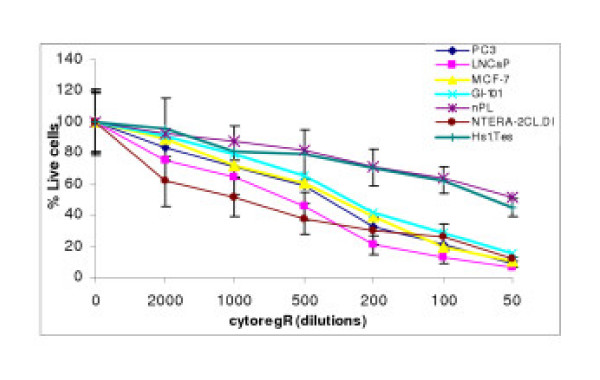
Growth inhibition of human adenocarcinoma cells. Cells were grown and treated with cytoregR for up to 48 hr as described in the methods Cell viability was assessed by the ability of live cells to metabolically reduce MTS Cell viability was assessed by the ability of live cells to metabolicallyreduce MTS to purple formazan after treatment with cytoregR for 48 hr. Percentage viability was determined by setting the absorbance of control, non-treated cells as 100%. Values represent the means + SEM of triplicates from two independent experiments Bars = SEM